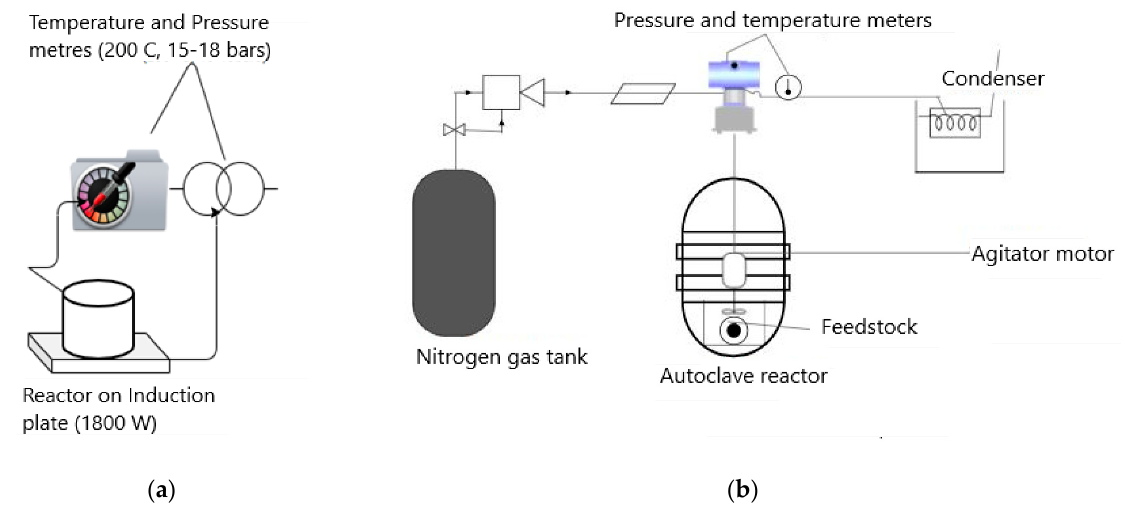
Figure 12. Schematic of ( a ) the hydrothermal carbonization (HTC) reactor and ( b ) the activation set up.